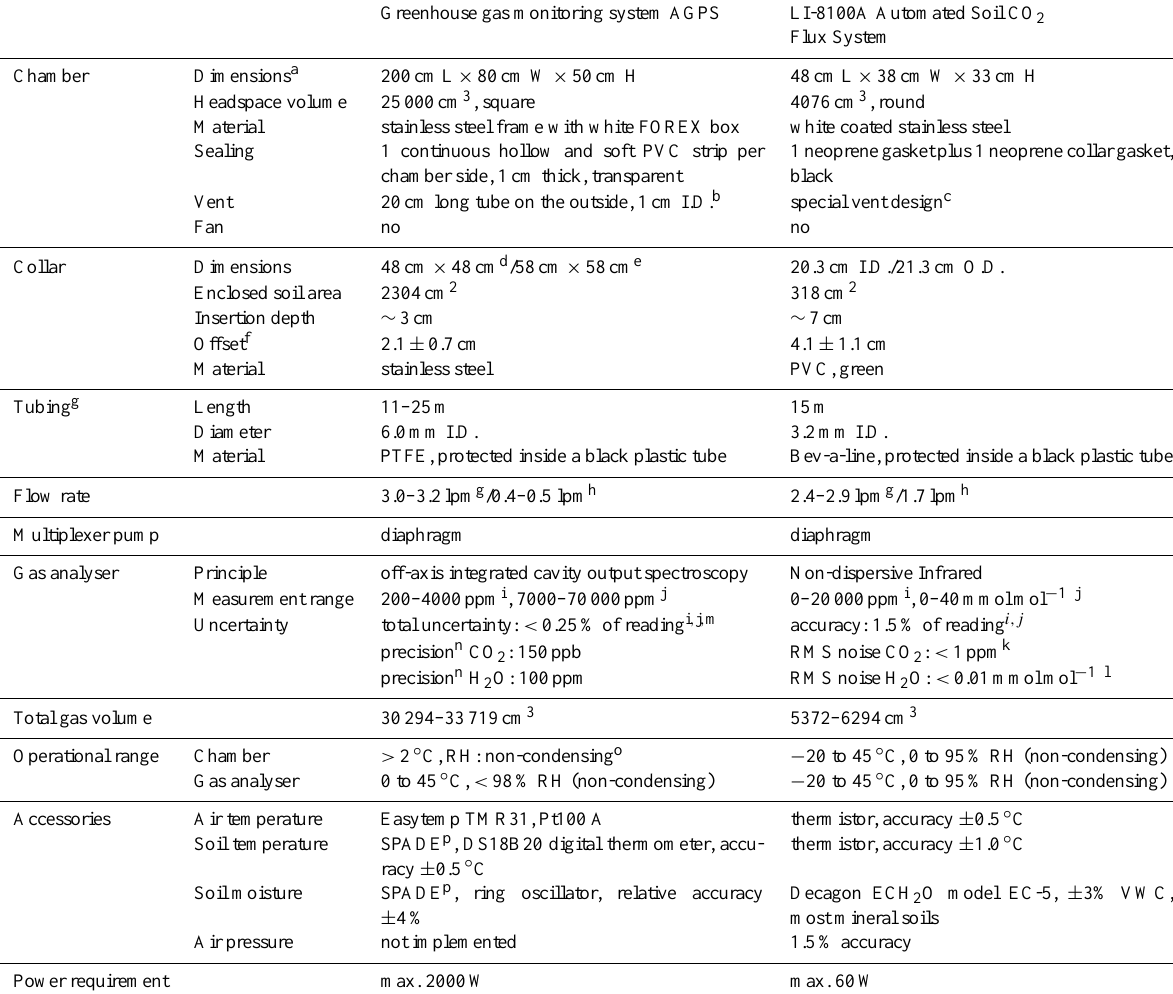
Table 1. Technical specifications of the two tested automated chamber